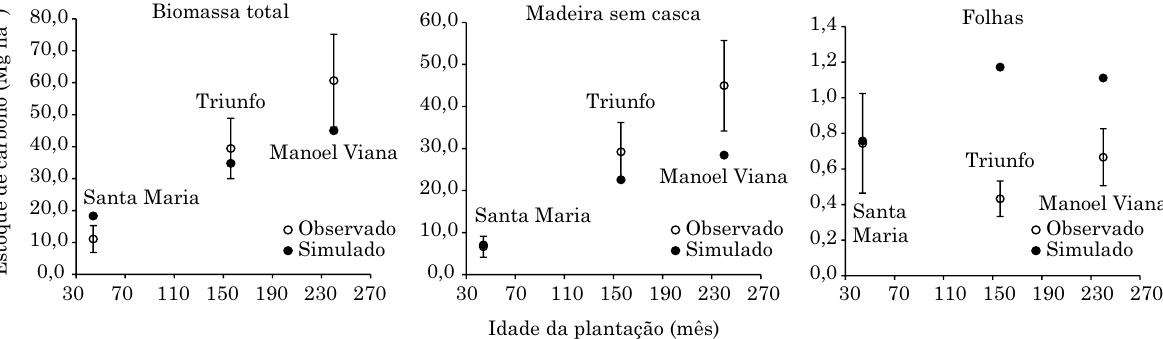
Figura 1. estoque de carbono observado e simulado durante a calibração do modelo Century 4.5: na biomassa total (acima e abaixo do solo); na madeira sem casca; e nas folhas das plantações de eucalipto de Santa Maria (Euc44), Triunfo (Euc156) e de Manoel Viana (Euc240), RS. Barras verticais: desvio- padrão em relação à média dos valores